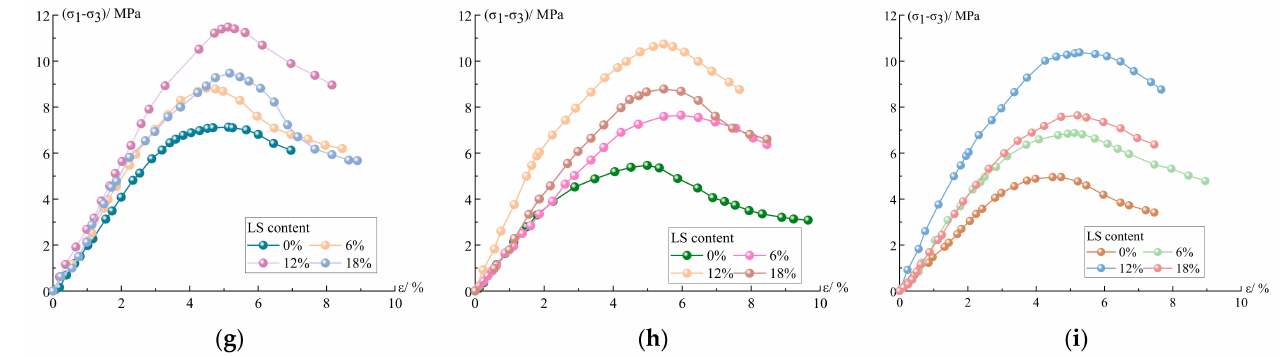
Figure 7. Triaxial compressive stress–strain curve: ( a ) 0 freeze–thaw cycles under 0.3 MPa confining pressure; ( b ) 2 freeze–thaw cycles under 0.3 MPa confining pressure; ( c ) 4 freeze–thaw cycles under 0.3 MPa confining pressure; ( d ) 0 freeze–thaw cycles under 0.6 MPa confining pressure; ( e ) 2 freeze– thaw cycles under 0.6 MPa confining pressure; ( f ) 4 freeze–thaw cycles under 0.6 MPa confining pressure; ( g ) 0 freeze–thaw cycles under 0.9 MPa confining pressure; ( h ) 2 freeze–thaw cycles under 0.9 MPa confining pressure; ( i ) 4 freeze–thaw cycles under 0.9 MPa confining